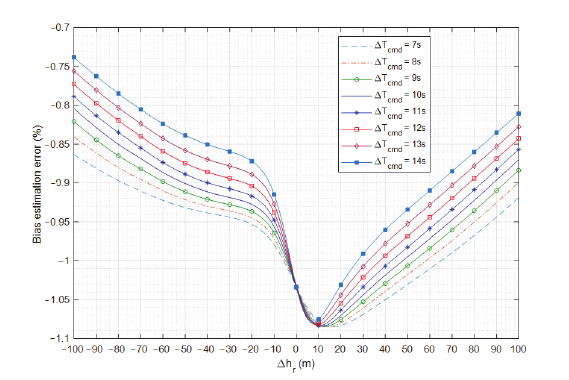
Figure 7. Result of bias calibration with various maneuvers